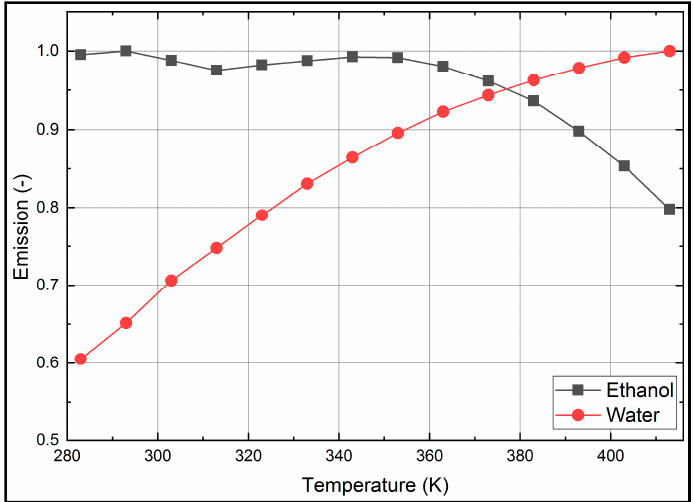
Figure 9. Normalized integral fluorescence intensities of Eosin-Y (15.86 mg/L) dissolved in ethanol and water for various temperatures, 0.1 MPa; the signals are normalized the respective maximum.